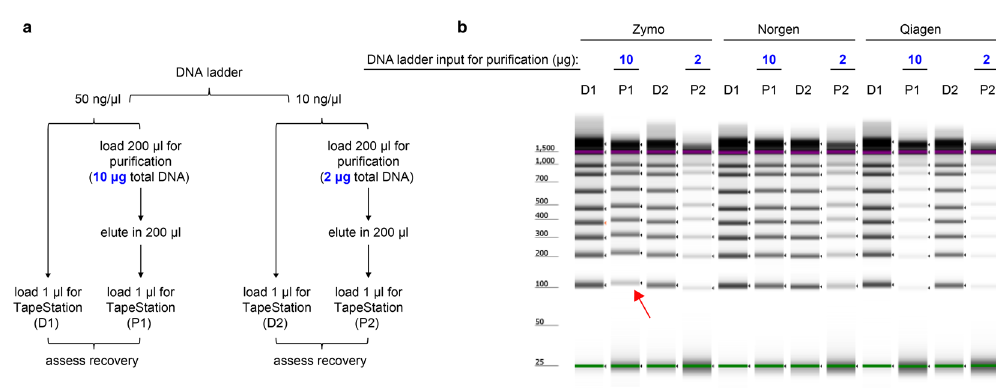
Figure 3. Comparison of DNA recovery of a ladder consisting of fragments as short as 100 bp using the Zymo Quick-DNA faecal/Soil Microbe Miniprep Kit (Zymo), the Norgen Stool DNA Isolation Kit (Norgen), and the QIAamp DNA Stool Mini Kit (Qiagen). ( a ) For direct visualization of DNA recovery from the three different purification processes, DNA ladder was either loaded directly onto TapeStation (D) or was subjected to one of the three purification protocols before being loaded onto TapeStation (P). Please note that band intensities between lanes D1 and D2 are not directly comparable because the higher input into D1 lanes may be beyond the linear range of the assay. In a 100% recovery scenario, the D and P lanes should contain the same amount of DNA. ( b ) A representative image of gel electrophoresis on TapeStation. The size marker lane was cropped out for clarity (the uncropped, full-length gel is presented in Supplementary Fig. S1). The purple and green lines in each lane represent internal upper and lower markers, respectively, for sizing and alignment. The red arrow denotes low recovery of the 100 bp band from the Zymo-extracted ladder